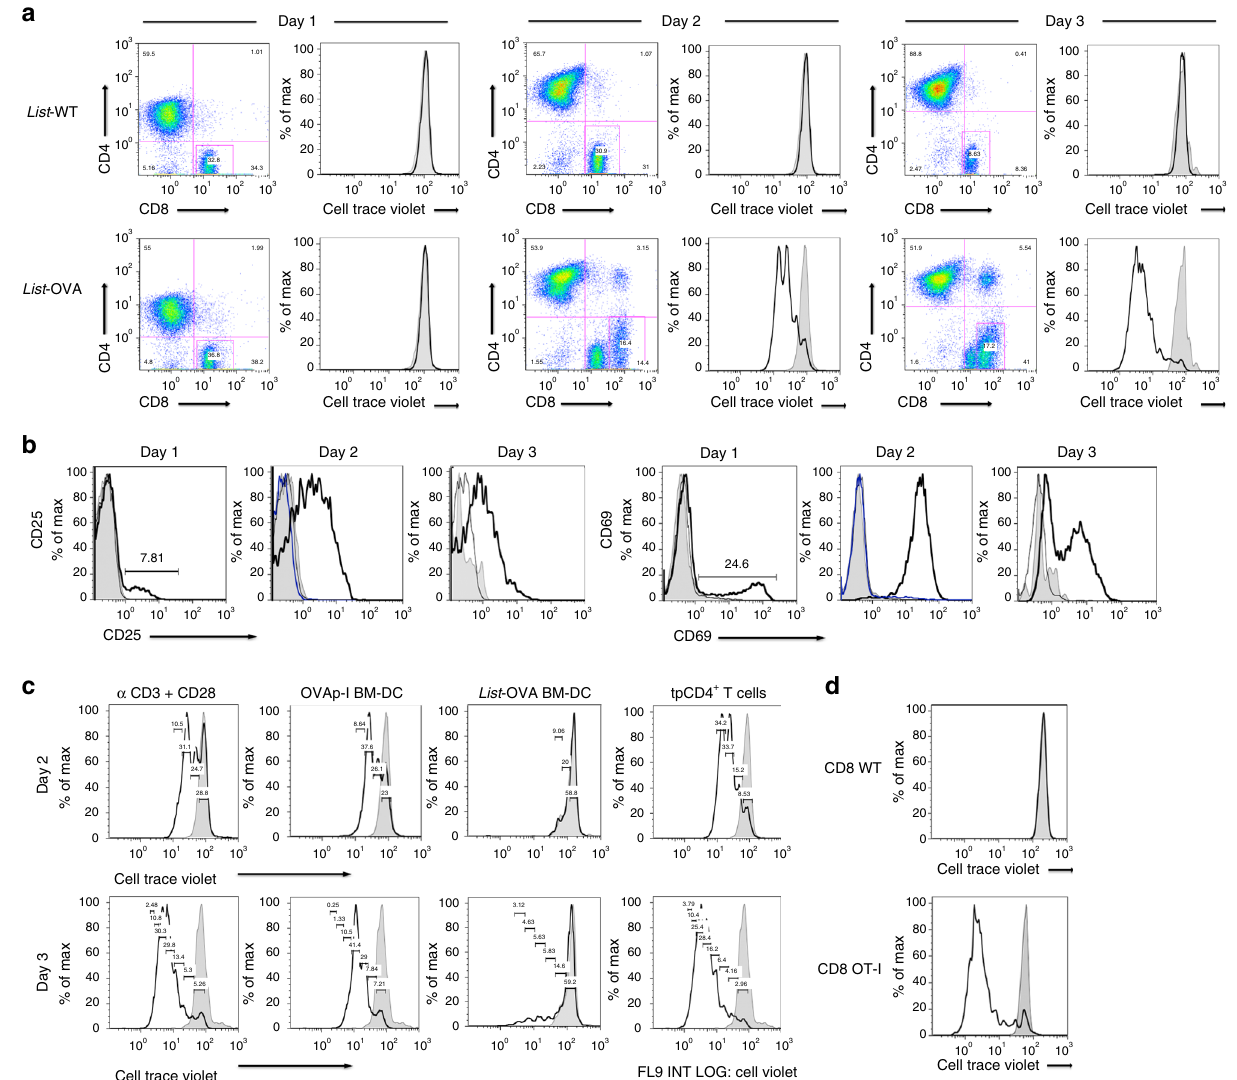
Fig. 1 tpCD4 + T cells prime naive CD8 + T cells. a OT-I naive CD8 + T-cell proliferation was measured by CellTrace Violet staining at 1, 2 or 3 days after contact with Listeria - WT (top) or Listeria - OVA (bottom) tpCD4 + T cells. Non-activated naïve CD8 + T cells are shown in grey. FACS gating is indicating in Supplementary Fig. 1D. b CD25 or CD69 expression by CD8 + T cells incubated with Listeria-WT (thin black line) or Listeria-OVA (thick black line) tpCD4 + T cells. Non-proliferative CD8 low (blue), non-activated CD8 + T cells (grey). c Proliferation of CD8 + T cells activated by anti-CD3/CD28 antibodies, by OVAp-I-loaded BM-DC, by Listeria-OVA BM-DC, or by Listeria-OVA tpCD4 + T cells, on days 2 (top) or 3 (bottom) post-activation. Non-activated CD8 + T cells are shown (grey). d Proliferation of CD8 + T cells from C57BL/6-WT or OT-I mice after conjugation with Listeria-OVA tpCD4 + T cells. Non- activated CD8 + T cells are shown